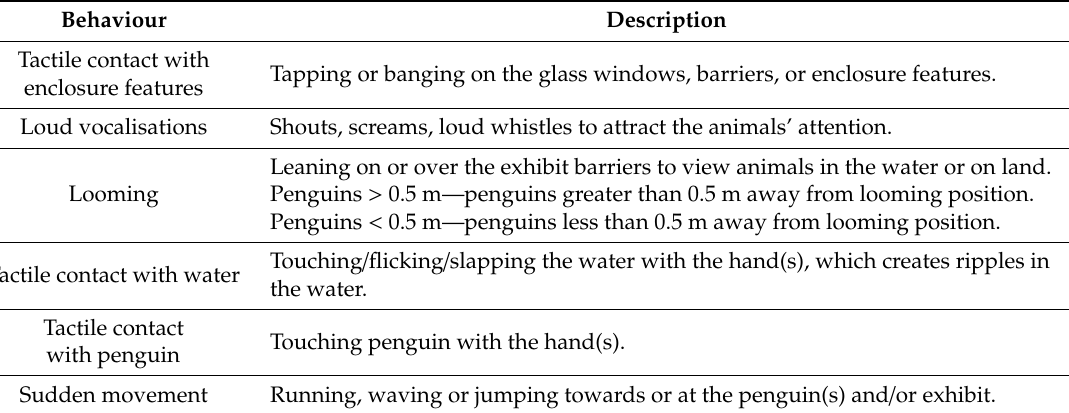
Table 2. Ethogram of visitor